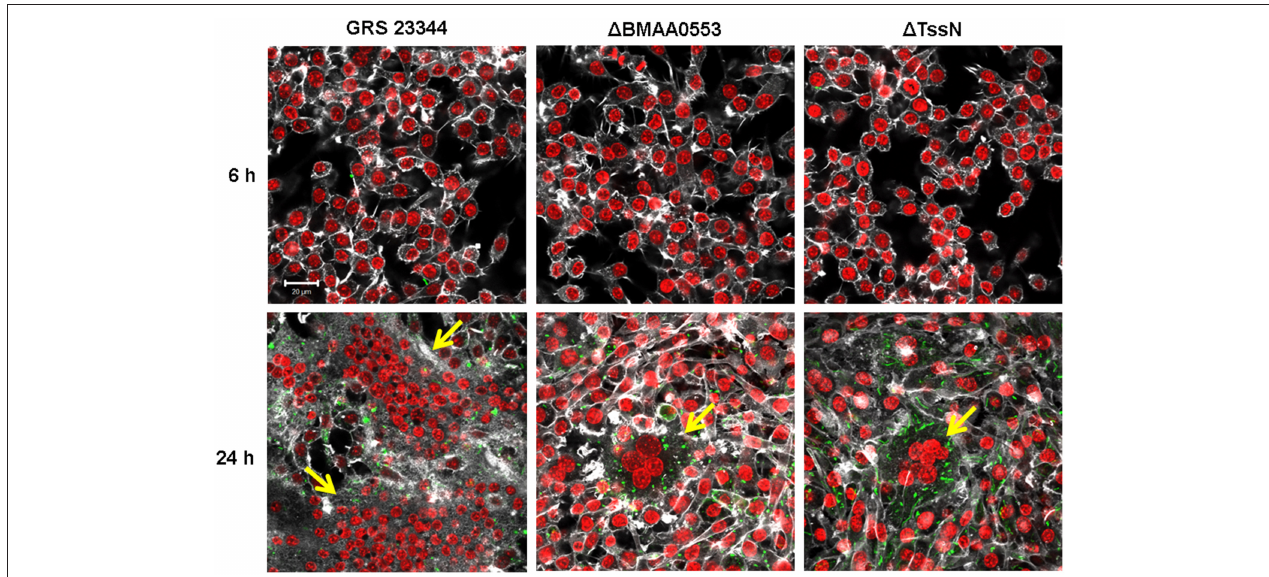
FIGURE 3 | Multinucleated giant cell (MNGC) formation in macrophage-like cells. RAW 264.7 cells were incubated with GRS 23344 ( left ), 1 BMAA0553 ( middle ), or 1 TssN ( right ) at an MOI of 1 for 6h ( top ) and 24h ( bottom ) before being stained for actin (white), macrophage nuclei (red) and Bm (green) and then visualized by confocal microscopy. The yellow arrows indicate the presence of a MNGC. Images are representative of three separate experiments. Scale bar = 20 µ m.